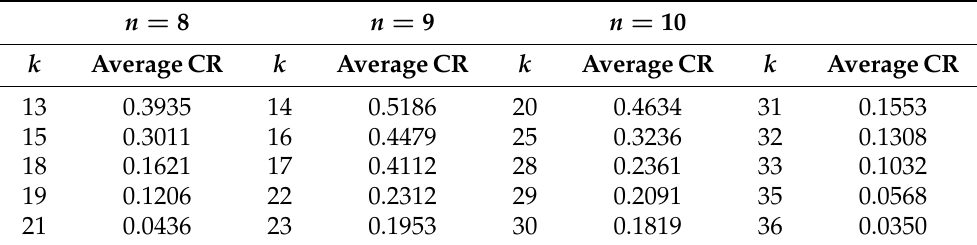
Figure 5. Computational time for the average CR of 10,000 matrices vs. number of missing comparisons k with respect to matrix size n corresponding to Table 4: ( a ) n = 4; ( b ) n = 5; ( c ) n = 6; and ( d ) n = 7,8,9,10. Table 6. Average CR of 10,000 random matrices from the Saaty scale for an arbitrarily large number of missing comparisons k with respect to matrix size n that continued from Table 4.